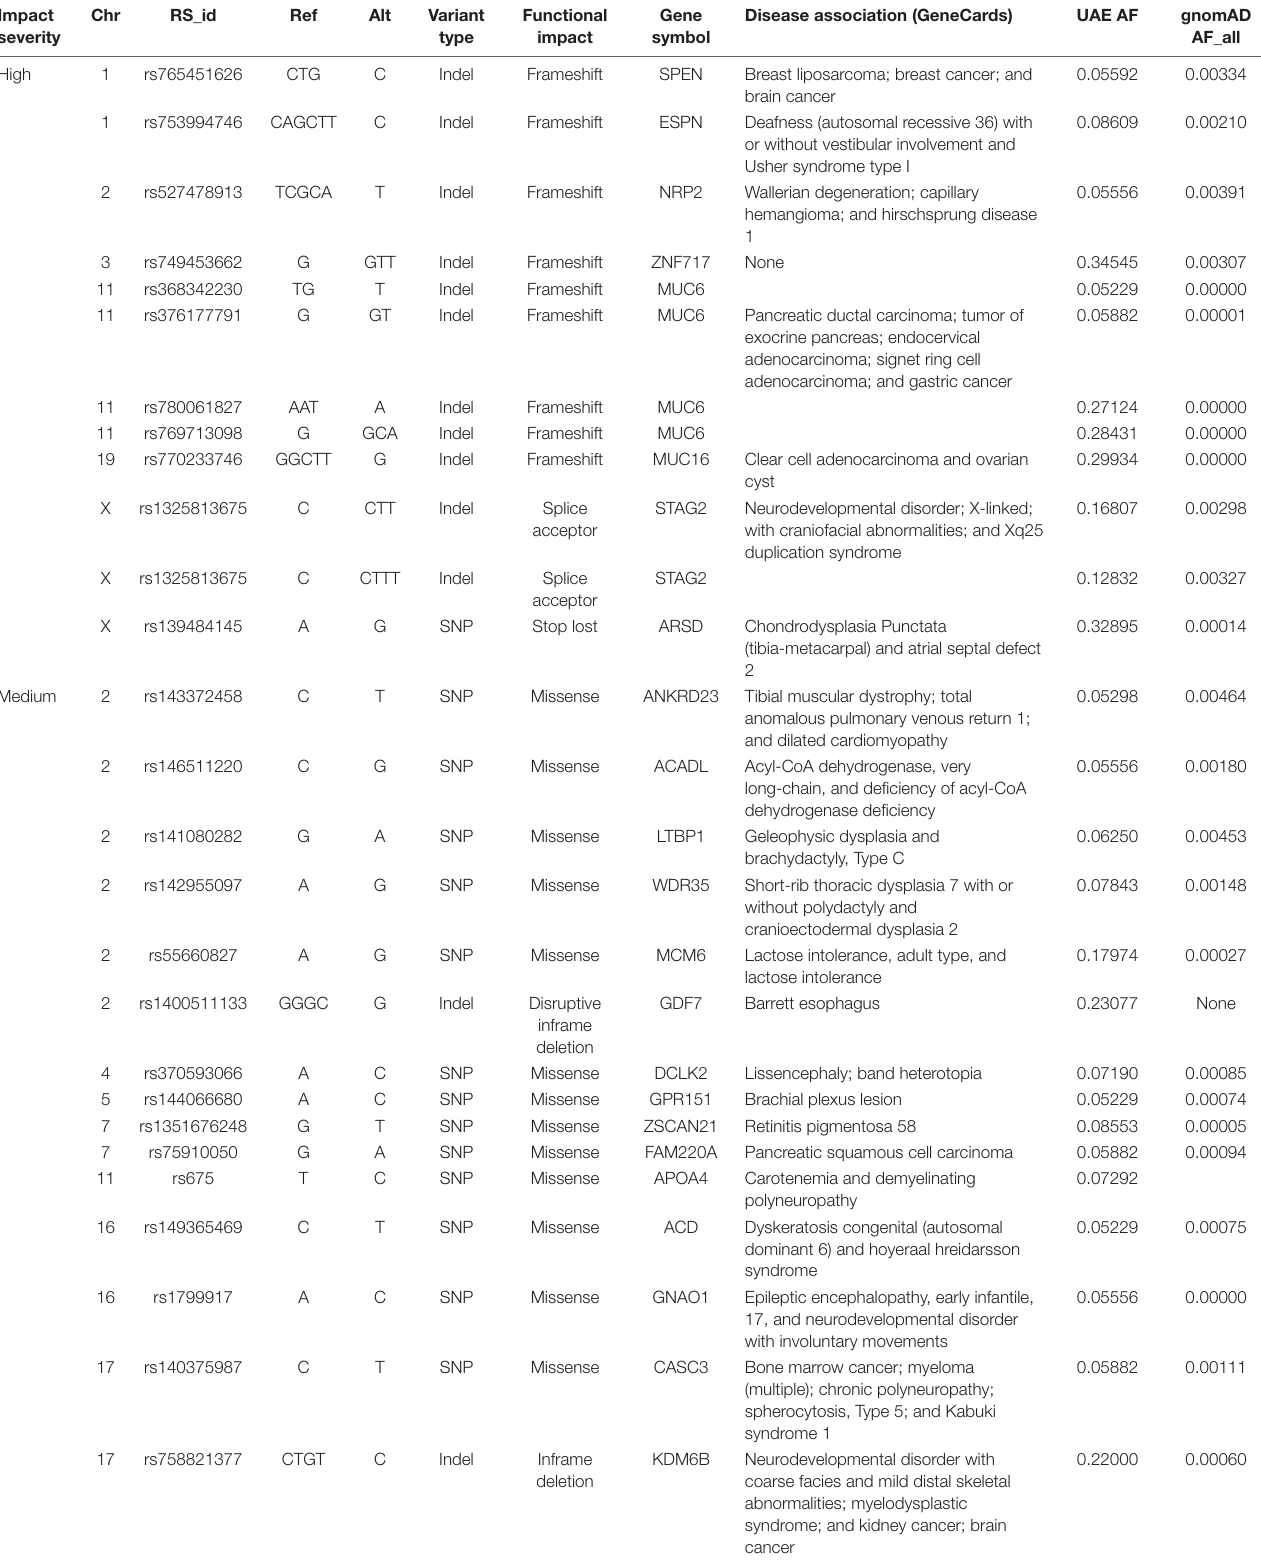
TABLE 5 | United Arab Emirates specific variants with high and medium functional impact